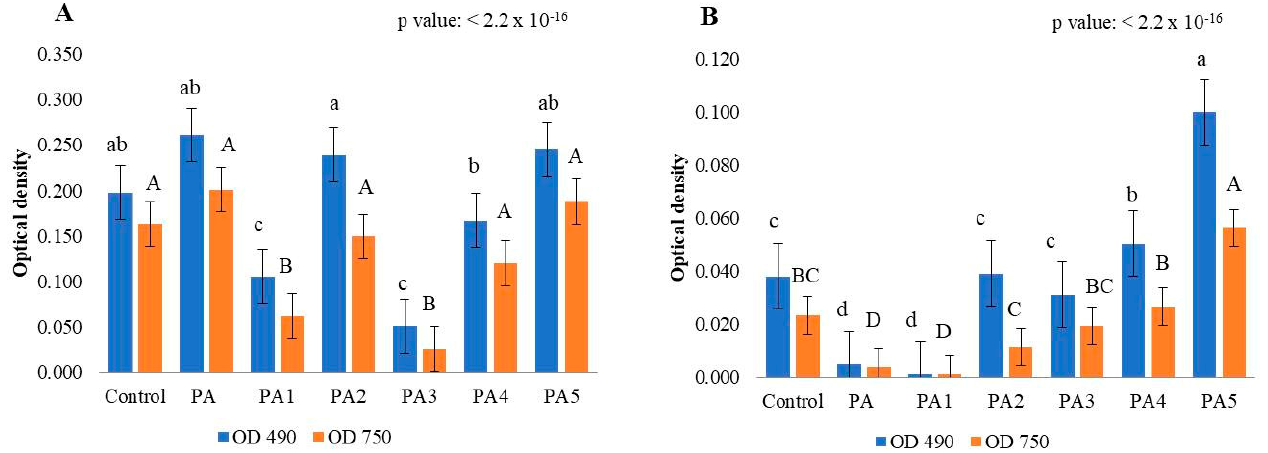
Figure 3. Optical density values from the MT2 microplates for the seven different analysed treatment of pyroligneous acid (PA) in function of FF inoculation fluid ( A ) and PDB medium ( B ). Each value is represented with the standard error. The lower-case letters (referring to the 490 nm optical density) and the upper case letters (for the 750 nm optical density) represent the results obtained after applying the post hoc Wilcox test (Tables S1, S3, S4, S6, S7, S9, S10 and S12). Abbreviation: Control is without adding PA; PA is PA pure; PA1 is PA 1:2; PA2 is PA 1:8; PA3 is PA 1:16; PA4 is PA 1:32; and PA5 is PA 1:36.